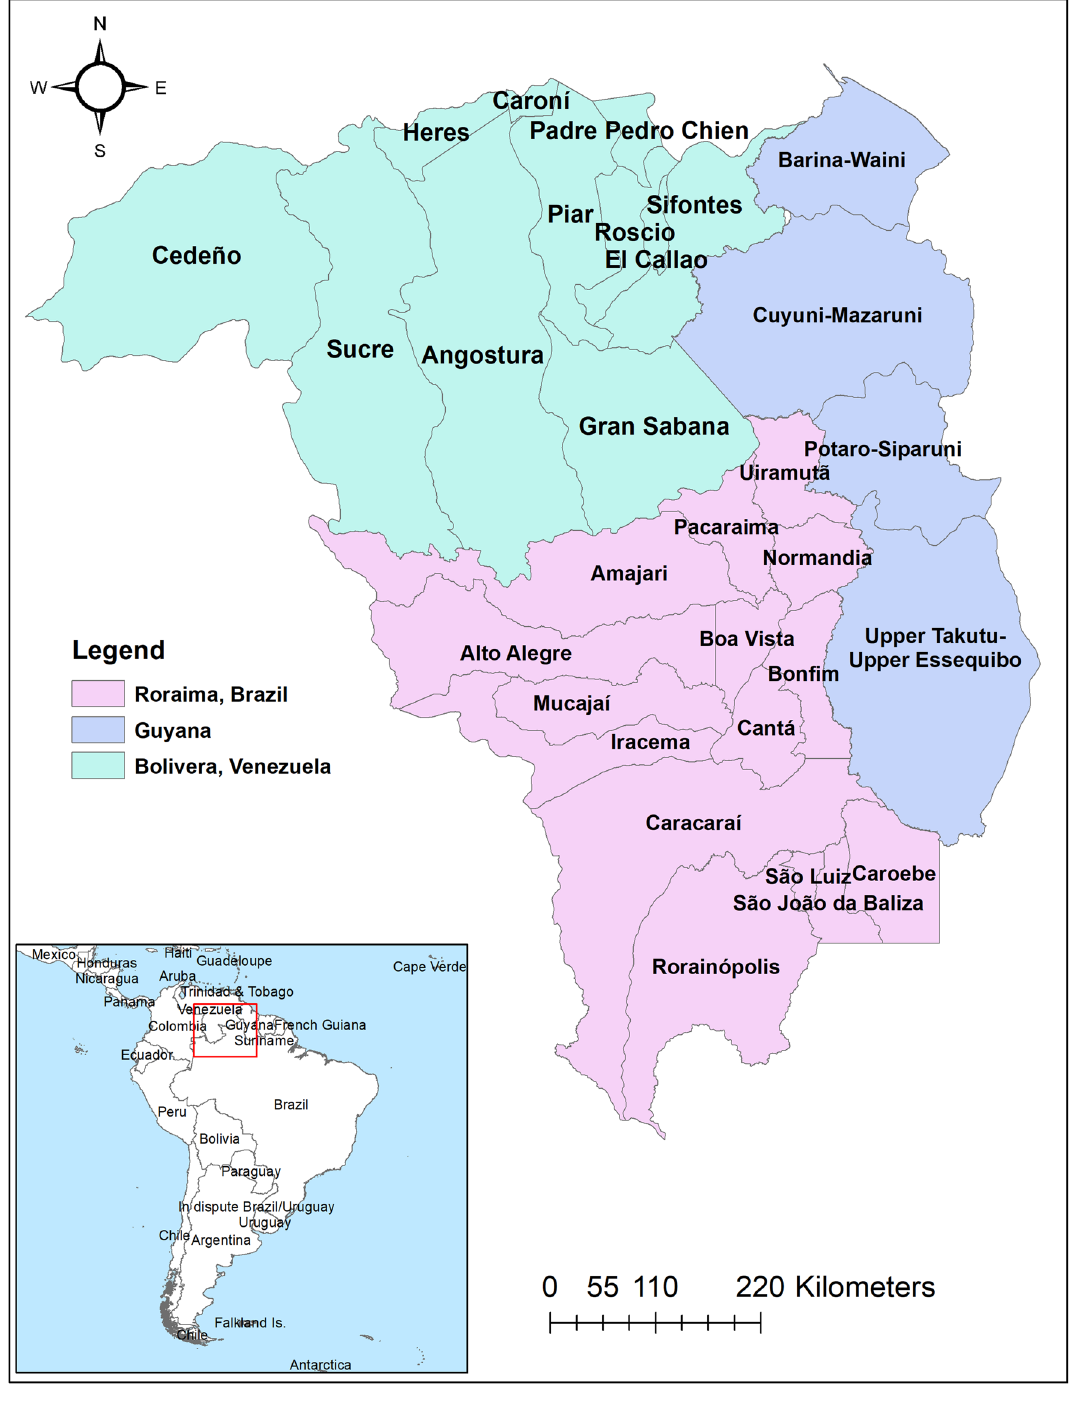
Figure 1. Map of the study